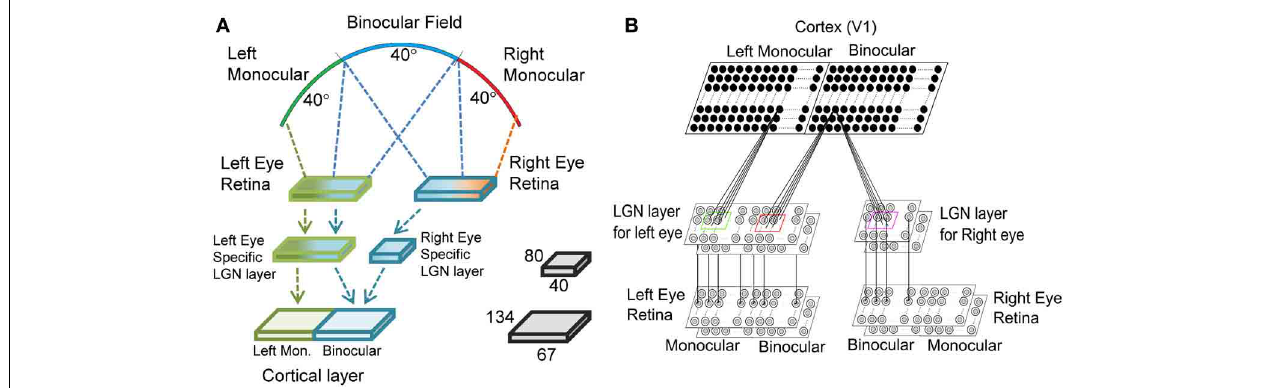
FIGURE 1 | The three layered visual pathway model. We have modeled 40 ◦ of binocular and left monocular visual fields each as shown in (A) . The left and the right eye retinae are 80 × 80 each. The left eye specific LGN layer is 80 × 80 with 40 × 80 region getting input from left monocular field and the rest 40 × 80 region from binocular field of vision. The right eye specific LGN layer is 40 × 80 and receives input from binocular field of vision. The cortical layer in the right hemisphere has